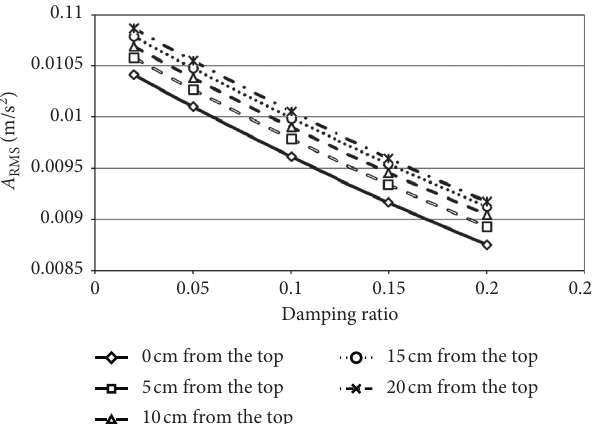
Figure 9: The effects of the damping ratio on vibration reduction (at monitored point E; damping layer thickness � 30mm).